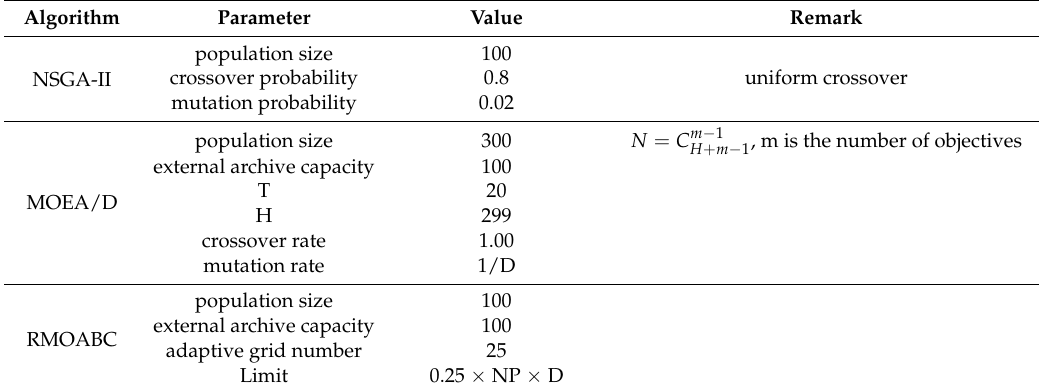
Table 1. The parameter settings of the three multi-objective